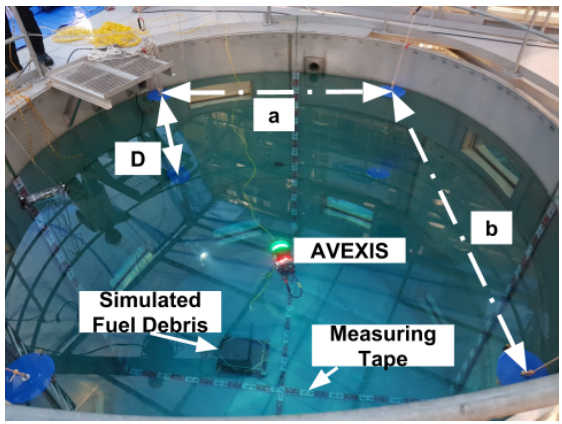
Figure 13. Setup of the markers in the Naraha Nuclear Test Facility. The four top markers (blue